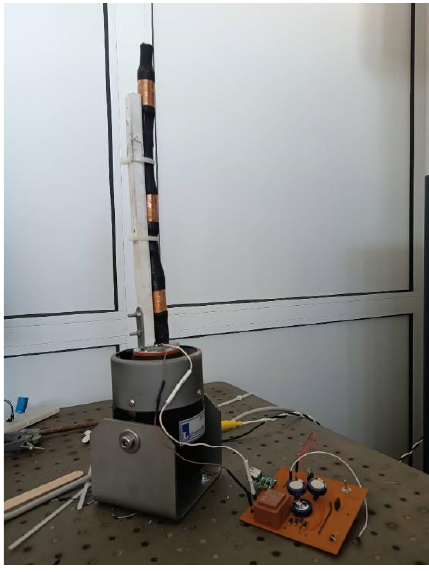
Figure 8. Oscillation generator connected to the power management circuit.